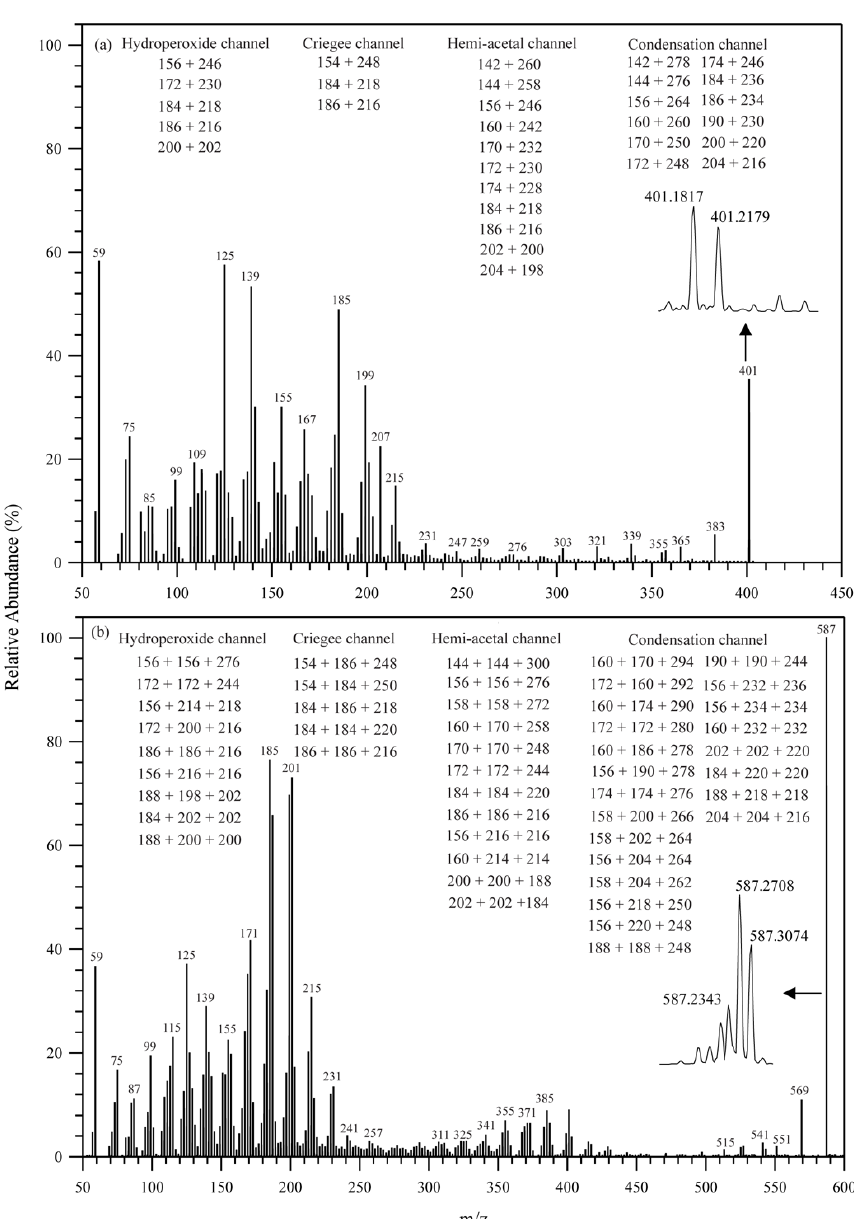
Fig. 8. Product ion mass spectra for the fragmentation of m/z 401 ± 2 in (a) and m/z 587 ± 2 in (b) . Infrared multiphoton dissociation technique (IRMPD) was used for the fragmentation of isobaric masses using FT ICR-MS. The combinations of building units for the reaction channels that form m/z 401.1817 and m/z 401.2179 are shown in (a) . The combinations of building units for the reaction channels that form m/z 587.2343, m/z 587.2708 and m/z 587.3074 are shown in (b) .